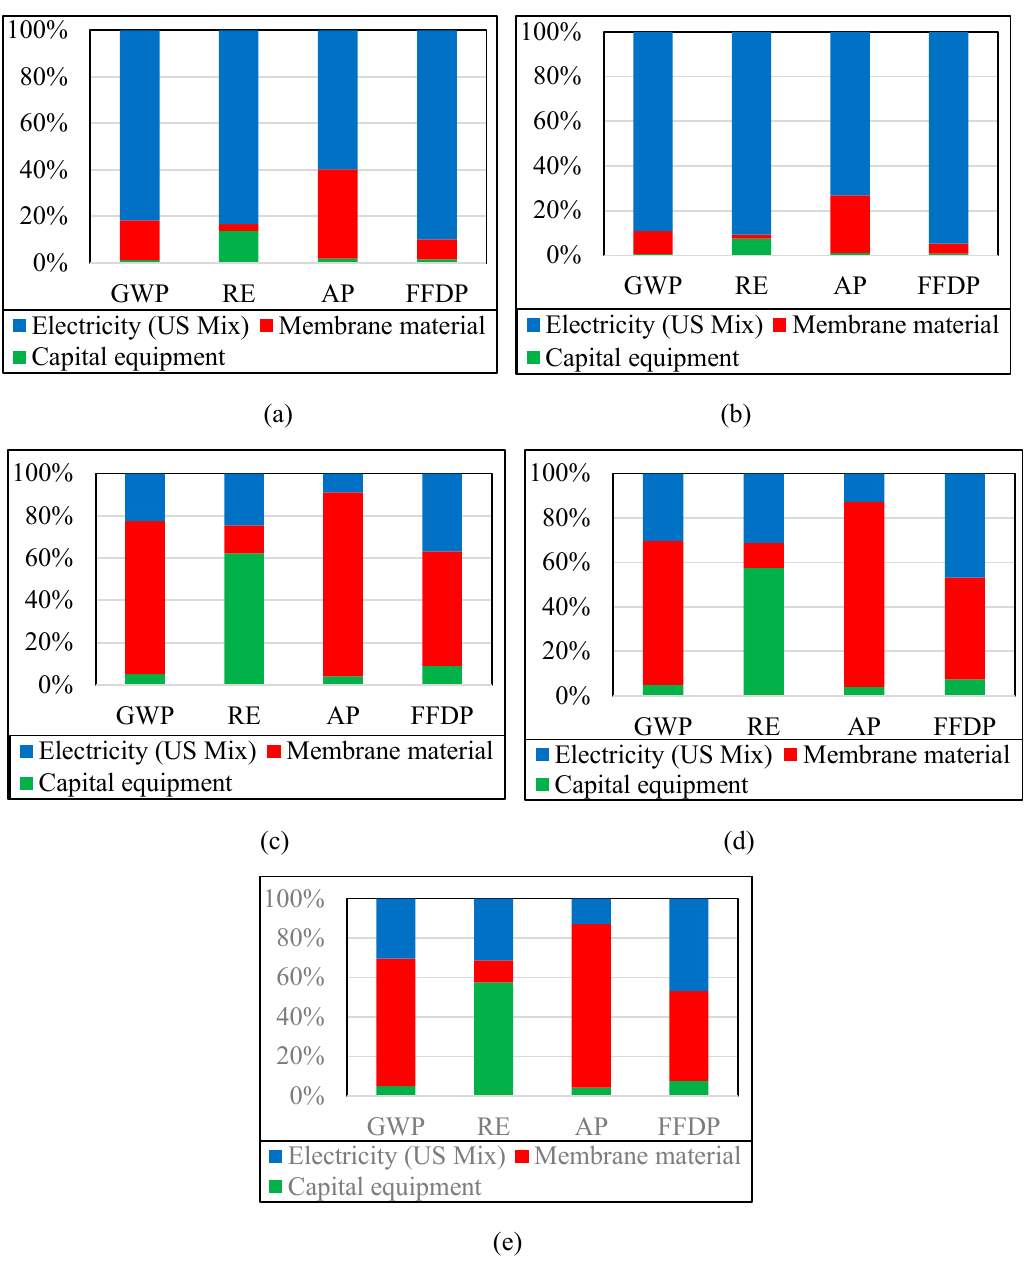
Figure 5. Analysis of contributions of the three-stage CO 2 enrichment process with ( a ) MEEP, ( b ) MEEP/CN, ( c ) Pebax LE, ( d ) Pebax HE, and ( e ) Pebax ZIF-8 membranes.